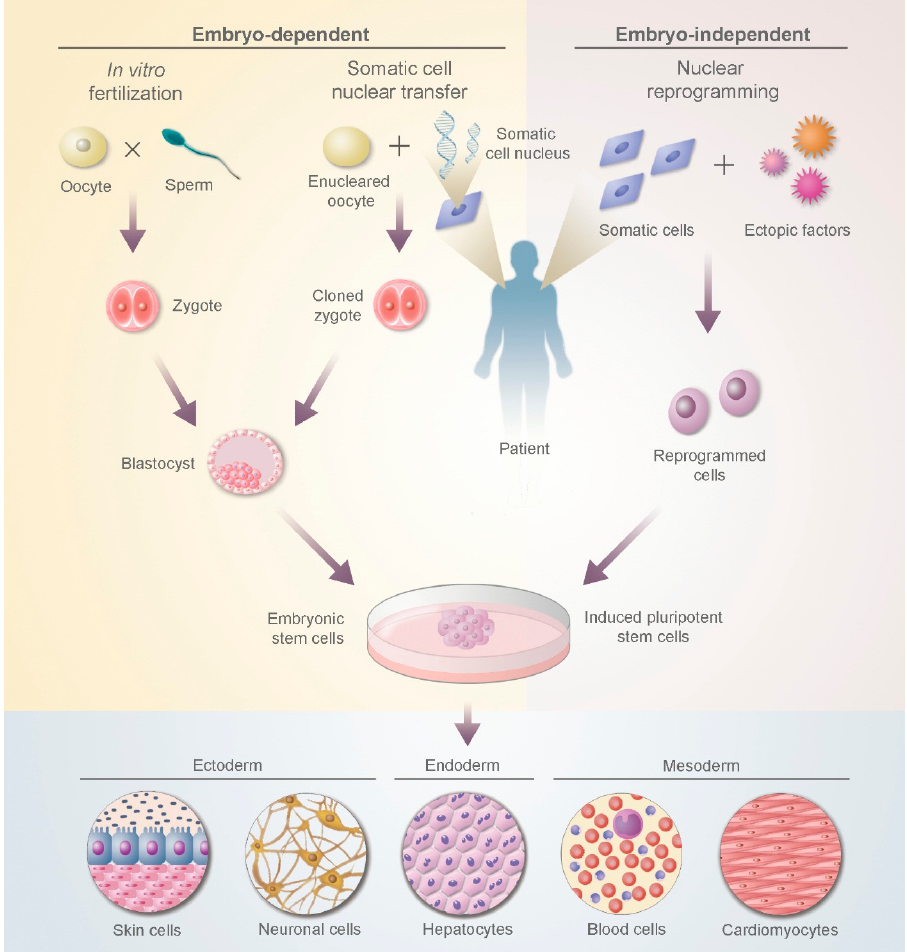
Figure 1. Production of embryonic stem cells and induced pluripotent stem cells.